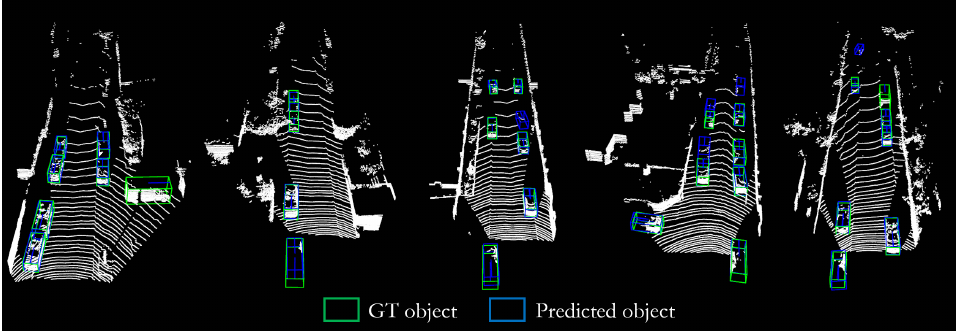
Figure 5. 3D object detection results of PSPSL-3D trained with R anno = 8%-labeled data in simple traffic scenarios. Few false-positives and true-negatives were